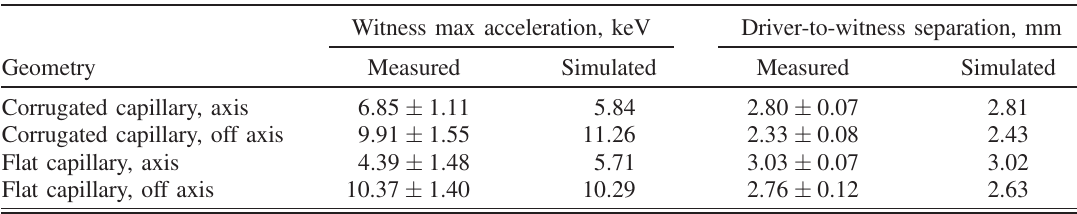
TABLE IV. Maxima of witness bunch